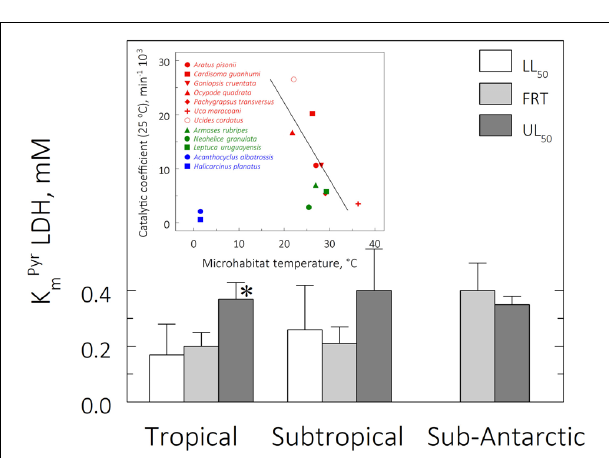
FIGURE 6 | Michaelis-Menten constants (K mPyr , mM) for muscle lactate dehydrogenase (LDH) in tropical, subtropical and sub-Antarctic crab species at their respective lower (LL 50 ) and upper (UL 50 ) critical thermal limits after 6 h direct transfer from the corresponding field reference temperatures (FRT) of 26, 15, and 9 ◦ C. Data are the mean ± SEM (2 ≤ N ≤ 3, pools of 3 individuals each). LDH activity was measured continuously in duplicate aliquots at the same experimental temperatures. Measurements could not be made for the sub-Antarctic species at their lower critical thermal limits. *Significantly different from tropical and subtropical crabs (phyHolm-Bonferroni, p ≤ 0.05). Insert : Catalytic coefficient (min − 1 10 3 ) calculated for 25 ◦ C, assuming a Q 10 of 2, plotted against the microhabitat temperature.